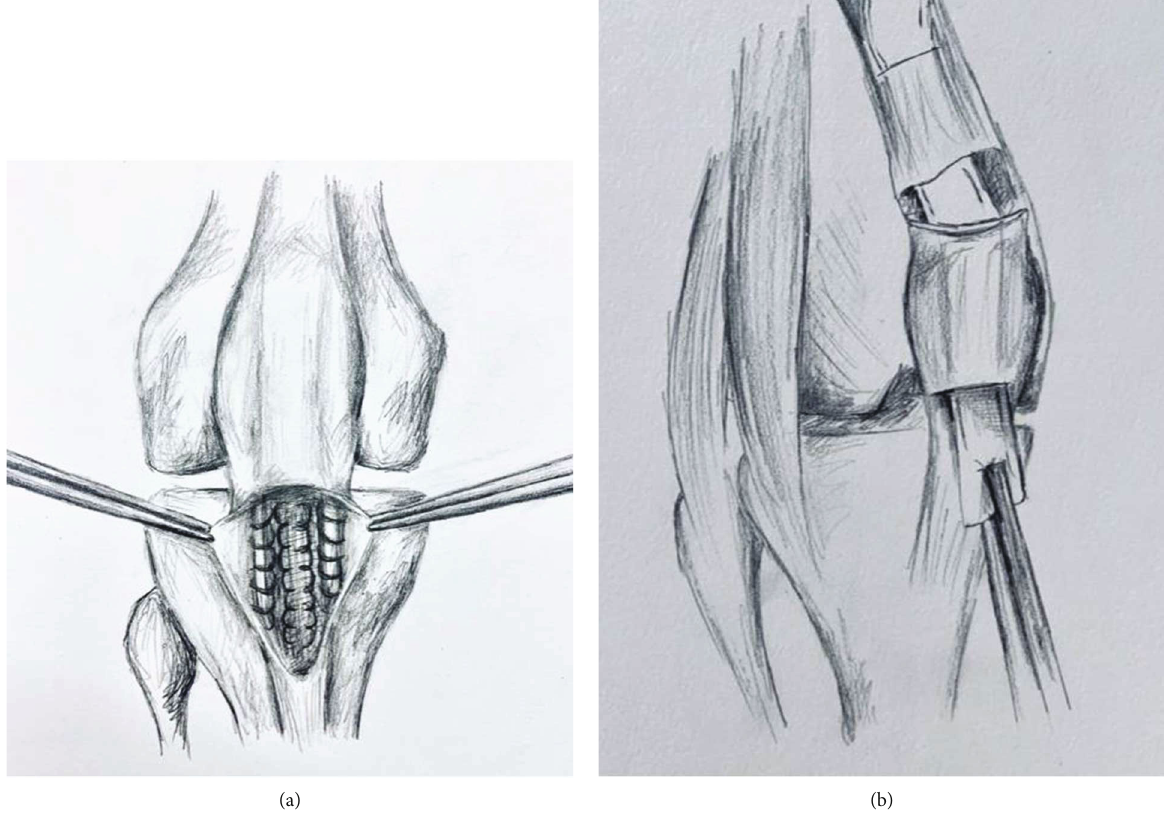
Figure 4: (a) Illustration of mesh fi xation distally into patellar tendon and deep to the paratenon layer. (b) Overview of passage of mesh subperiosteal over patella and into quadriceps